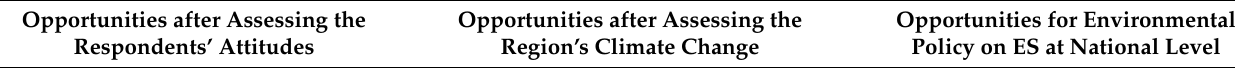
Table 3. Links between ES opportunities and the social well-being of the rural population of the Nemunas Delta and the Curonian